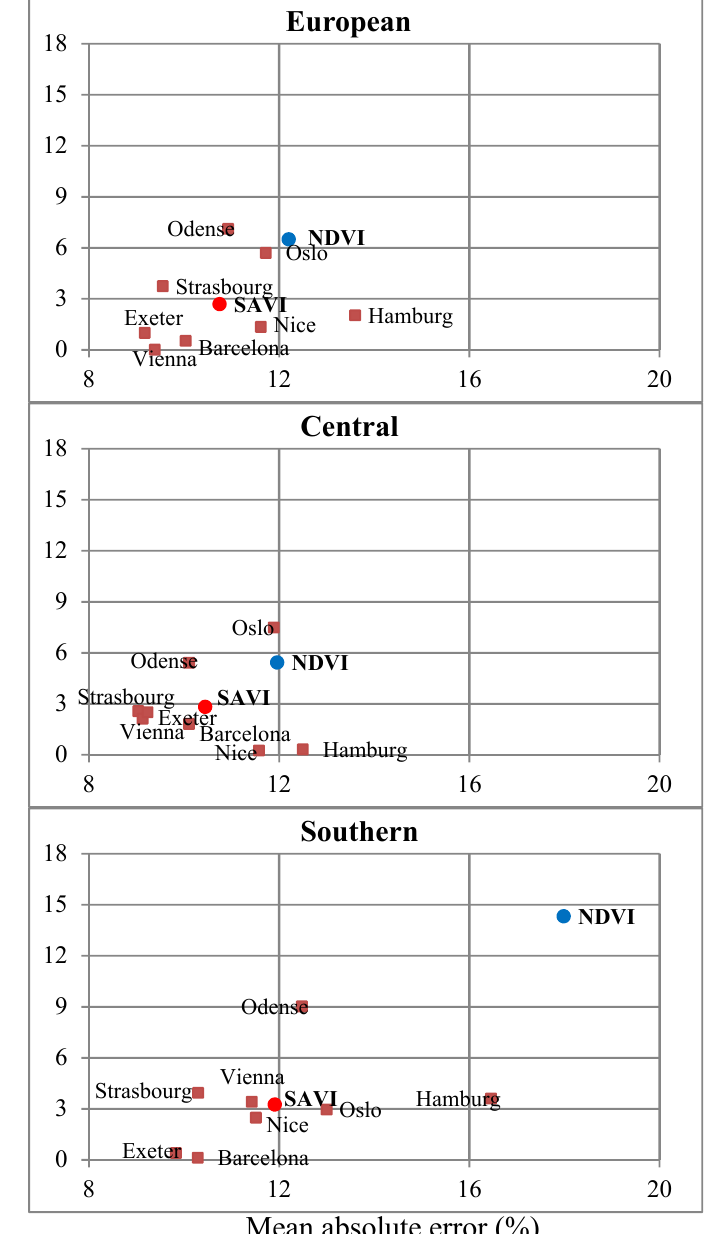
Figure 9. MAEs and absolute MBEs using the regional second order polynomial regression models based on NDVI and SAVI. European = sub-areas from all cities are included in the regression model, Central = sub-areas from Odense, Hamburg, Strasbourg, Exeter and Vienna are included in the regression model, Southern = Sub-areas from Barcelona and Nice are included in the regression model. NDVI and SAVI are the averages of the indices for the second order polynomial regression